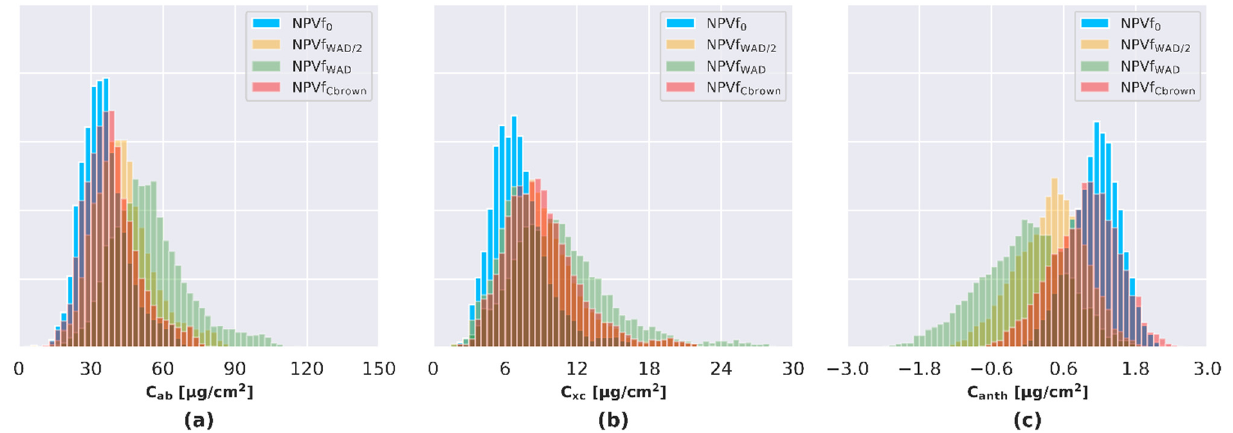
Figure 7. Pigment distribution computed for Site B, based on linear models relating spectral indices to pigment content, adjusted from the four NPVf scenarios applied on Site A. ( a ) C ab ; ( b ) C xc ( c ) C anth .